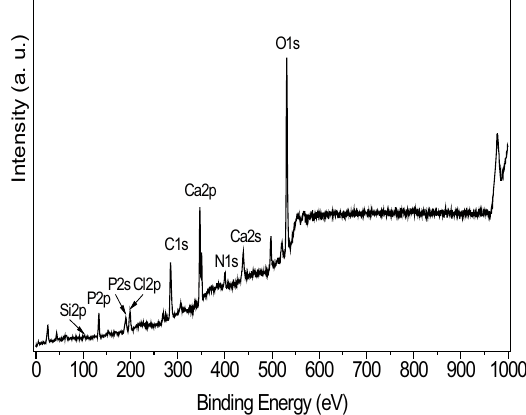
Figure 7. XPS spectrum for obtained G/S hybrid material 25:75 wt.% after immersion in 1.5 SBF for 3